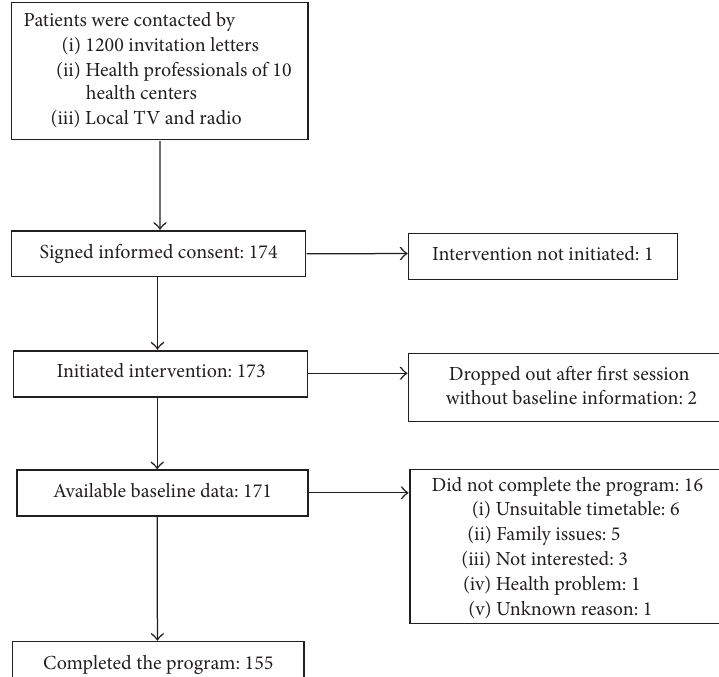
Figure 1: Flowchart of pilot study participants.